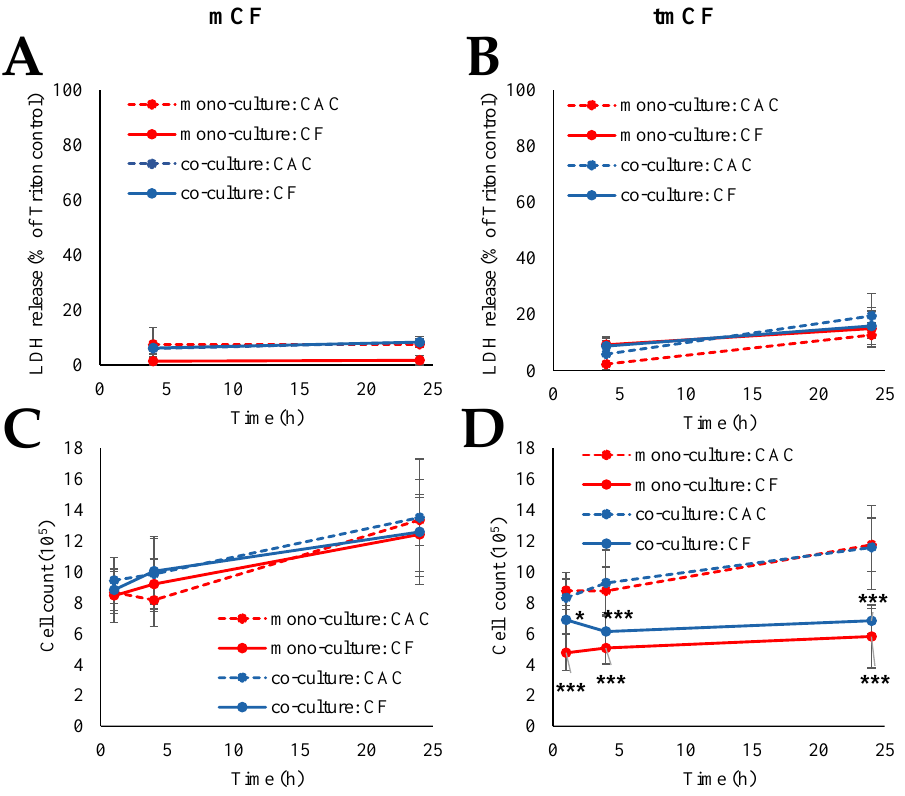
Figure 2. Assessment of cytotoxicity in BEAS-2B mono- and BEAS-2B/dTHP-1 co-cultures after exposure to mechanically treated CF (mCF) ( A , C ) and thermo-mechanically treated CF (tmCF) ( B , D ). BEAS-2B cells were seeded with a density of 2 × 10 5 /cm 2 . After 4 h, dTHP-1 cells (3.9 × 10 4 /cm 2 ) were seeded on top of the BEAS-2B cells for co-culture treatment. On the next day, mono- and co-cultures were exposed to CF samples with average surface doses of 7.00 ± 1.25 µ g/cm 2 (mCF, ( A , C )) or 6.55 ± 1.96 µ g/cm 2 (tmCF, ( B , D )) for 1 h and post-incubated for 0, 3, or 23 h. Clean air controls (CAC) were treated respectively. Cells were harvested for the determination of cell count ( C , D ). The supernatants were analyzed for LDH release ( A , B ), which is depicted relative to the Triton control (100%). The mean values ± SD of at least three independent experiments performed in duplicates are displayed. Statistical analysis was performed to assess differences between treated and untreated cells using Student’s t -test: * ( p ≤ 0.05), *** ( p ≤